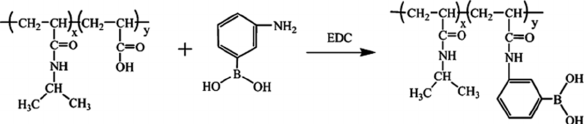
Figure 5: Synthesis of glucose-sensitive P(NIPAM-PBA) microgels with pendant 3-amino-phenylboronic acid. Adapted with permission from [41]. Copyright 2006, American Chemical Society